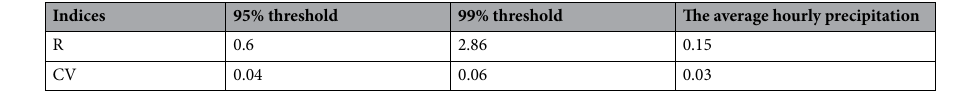
Table 3. Site differences in extreme precipitation thresholds and mean hourly precipitation.